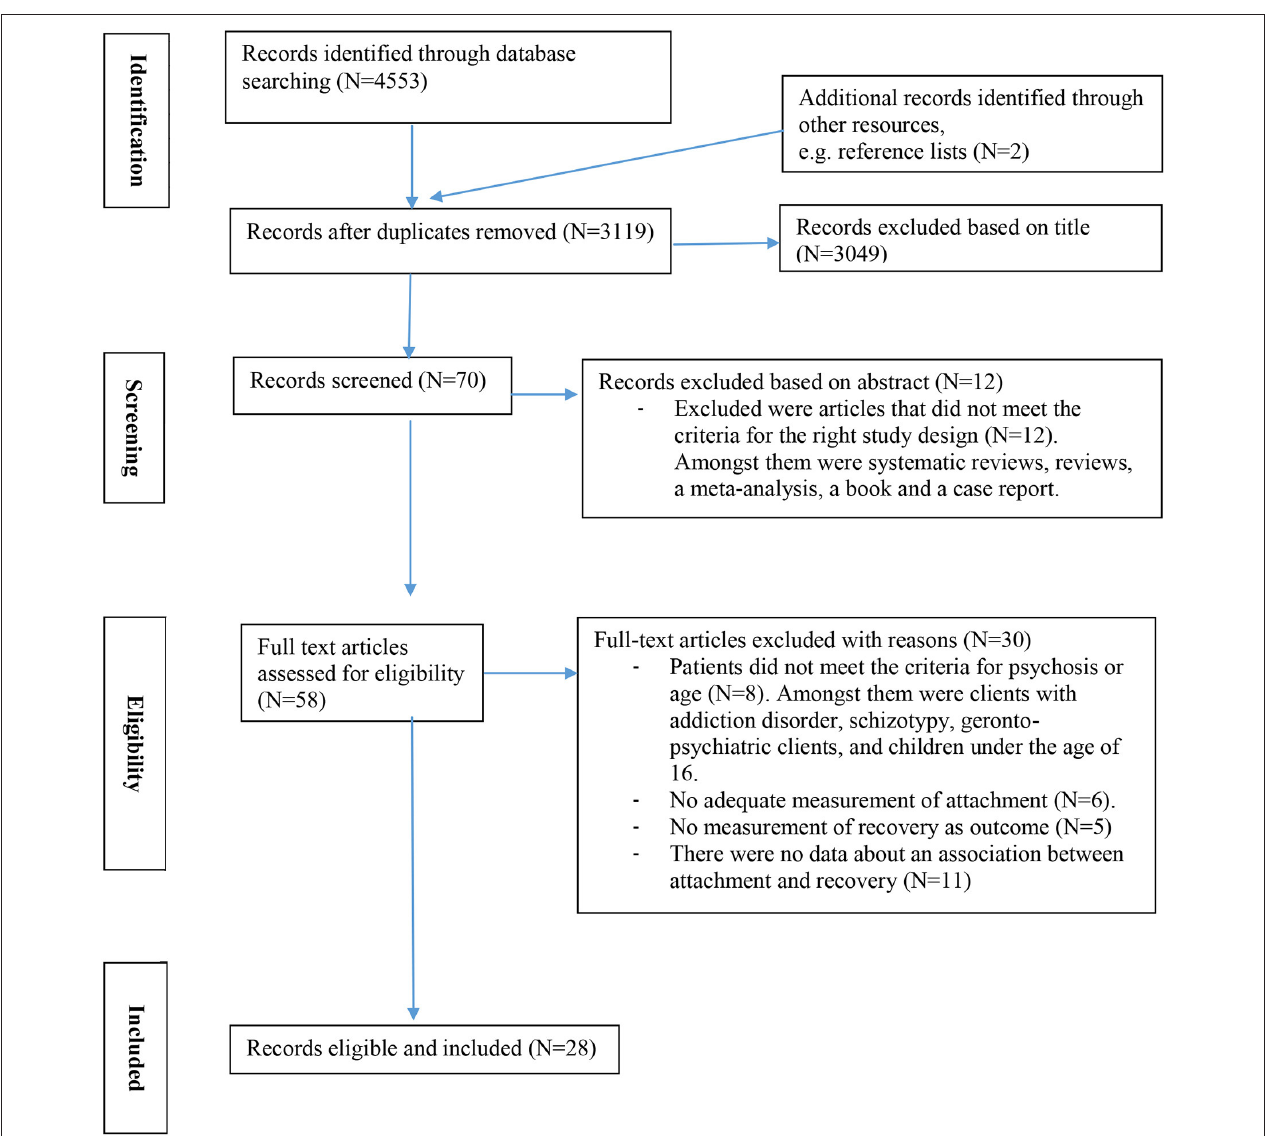
FIGURE 1 | PRISMA flow diagram of systematic